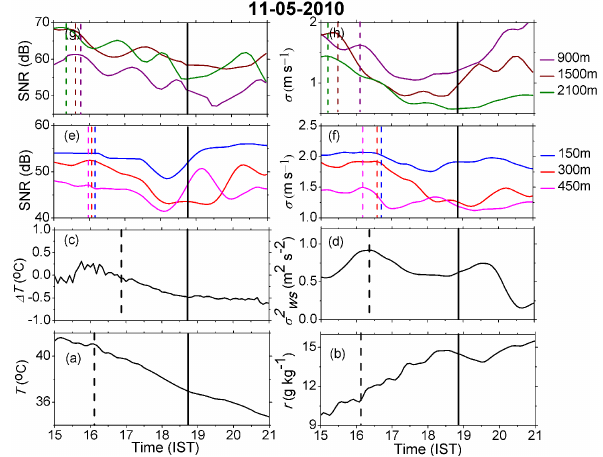
Figure 2. Temporal variation of state variables (at the surface and aloft) a few hours before and after the time of sunset (indicated with a black solid vertical line). Temporal variation of MBLM-derived (a) T , (b) r , (c) (cid:49)T and (d) σ 2 , sodar-derived (e) range-corrected WS SNR and (f) σ and profiler-derived (g) range-corrected SNR and (h) σ . The sodar- and profiler-derived parameters are plotted at three representative levels each (150, 300 and 450m for sodar and 900, 1500 and 2100m for profiler). Vertical dashed lines indicate the start time of the transition as identified by different state